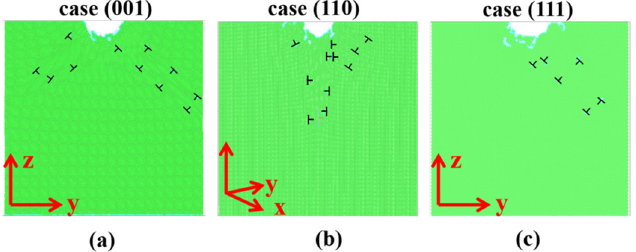
Figure 6. Atomic arrangement and dislocation distributions under the indented planes. ( a ) under the indented (001) plane, ( b ) under the indented (110) plane, and ( c ) under the indented (111) plane.